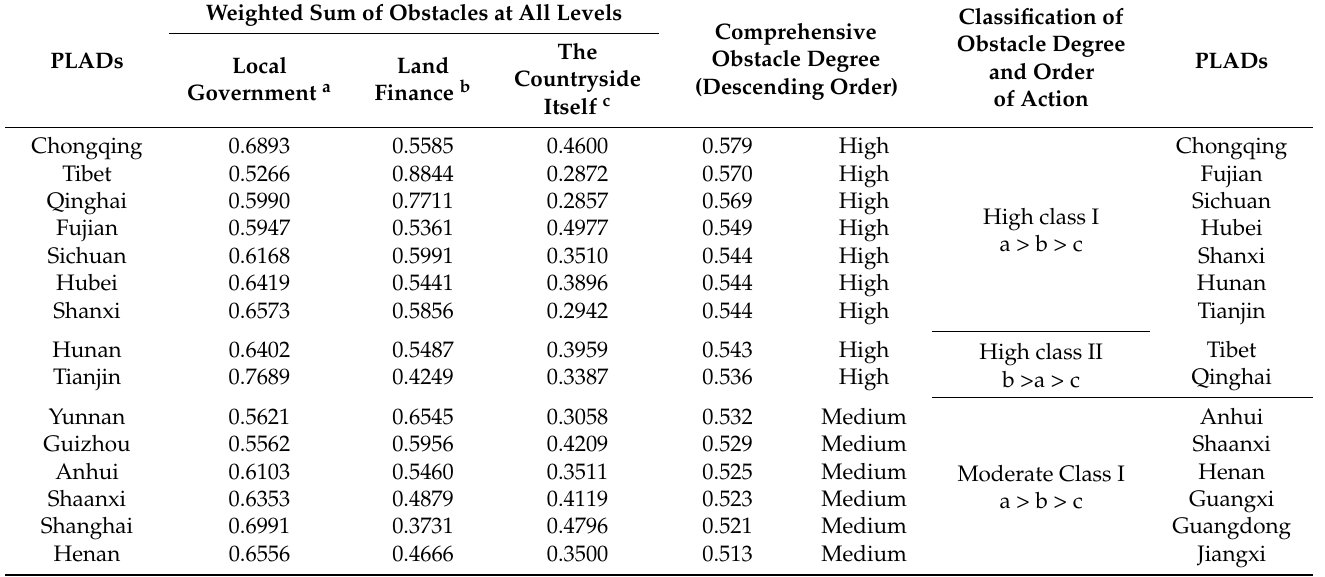
Table 2. Thirty-one PLADs’ land transfer income supports the potential comprehensive obstacles and types of rural